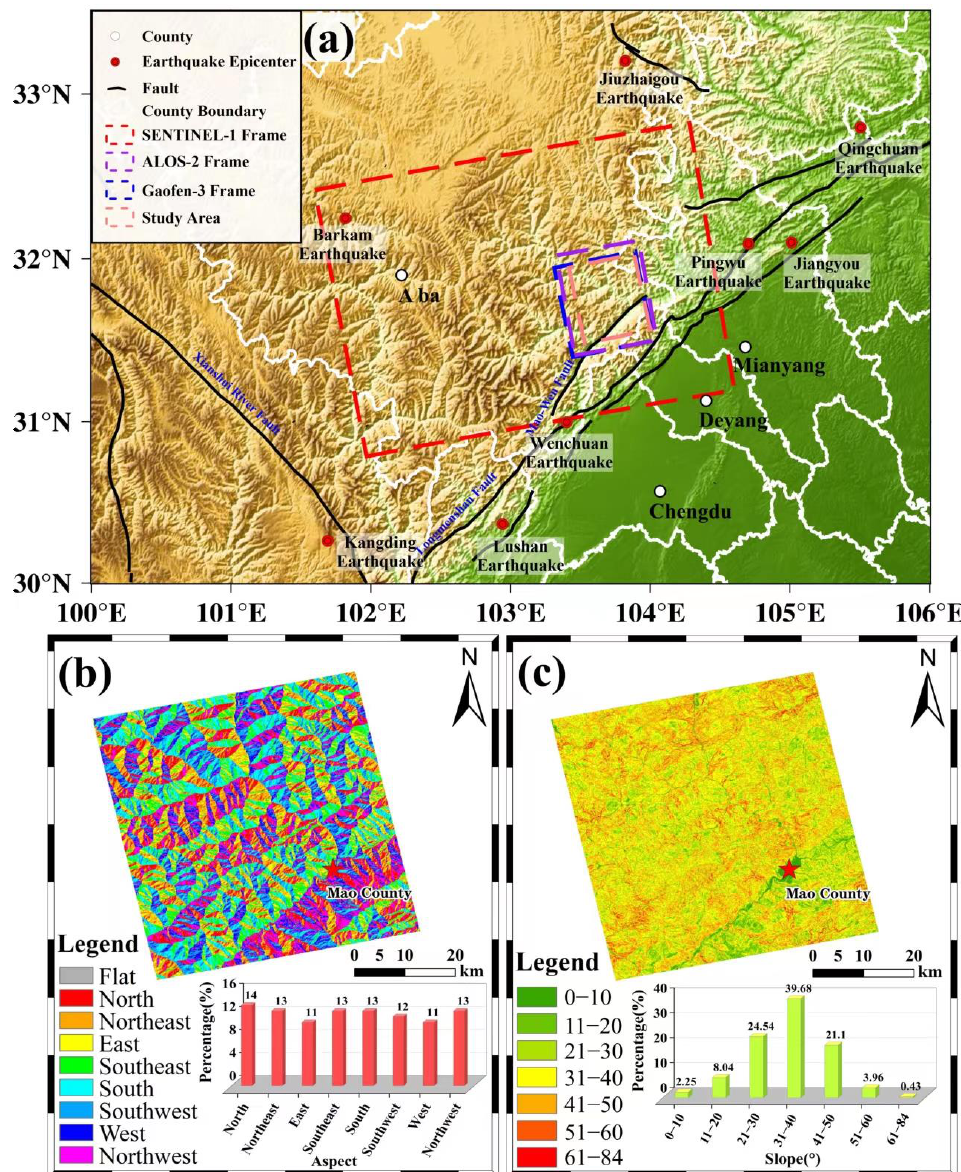
Figure 1. ( a ) Location of the study area and coverage of the datasets. ( b ) Slope aspect distribution of the study area. ( c ) Slope gradient distribution of the study area.